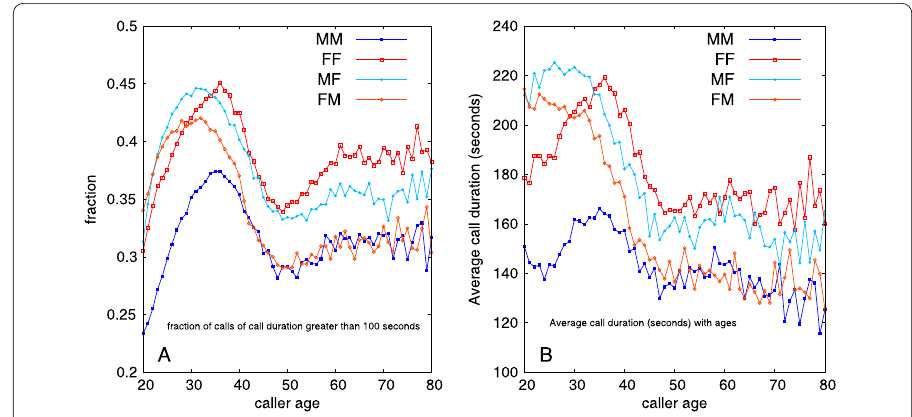
Figure 4 ( A ) The fraction of calls of duration greater than 100 seconds (out of all the calls made) as a function of the caller’s age for interactions between four types of caller–callee pairs. ( B ) The average call duration as